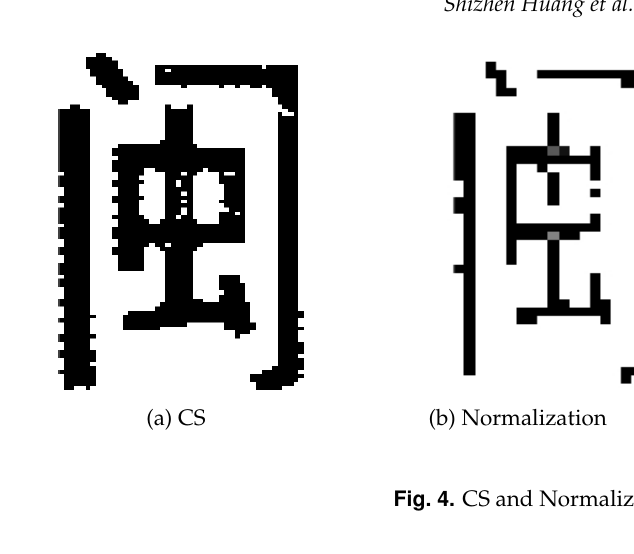
Table 2. ALPR Accelerator Resource Consumption